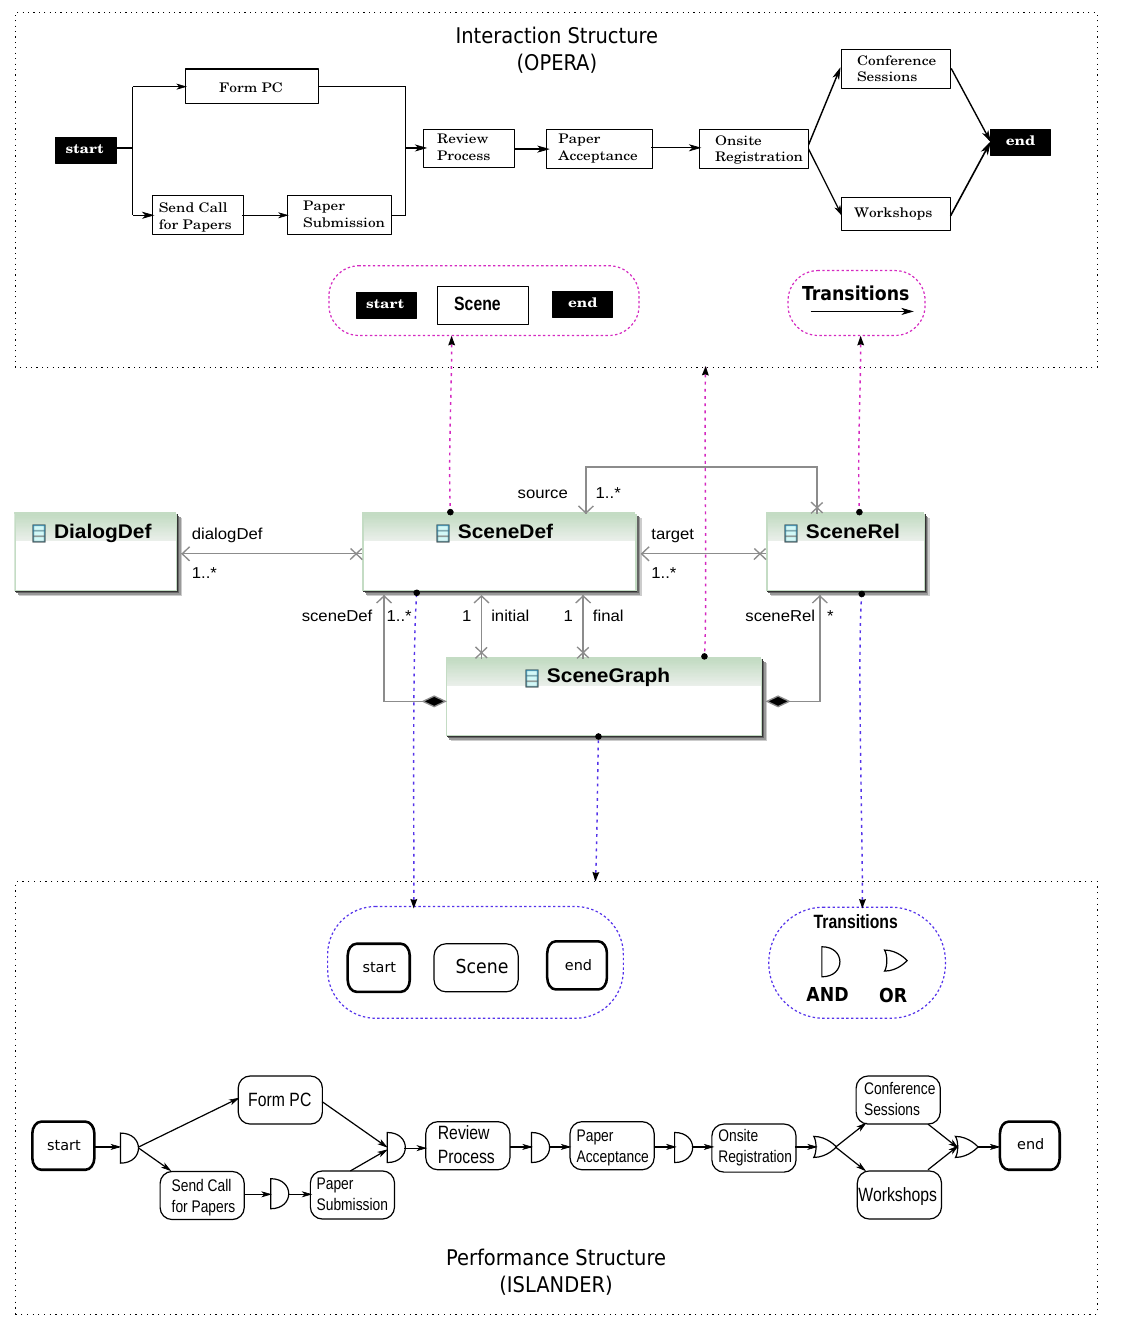
Figure 4. Similar dialogical specifications written in OPERA and ISLANDER for an agent based conference management system (example taken from [27] chapter 3). The class diagram (Ecore metamodel) in the center represents the conceptual pattern identifiable in the two approaches of dialogical modeling. The dotted arrows detail what concepts are captured by what classes of the